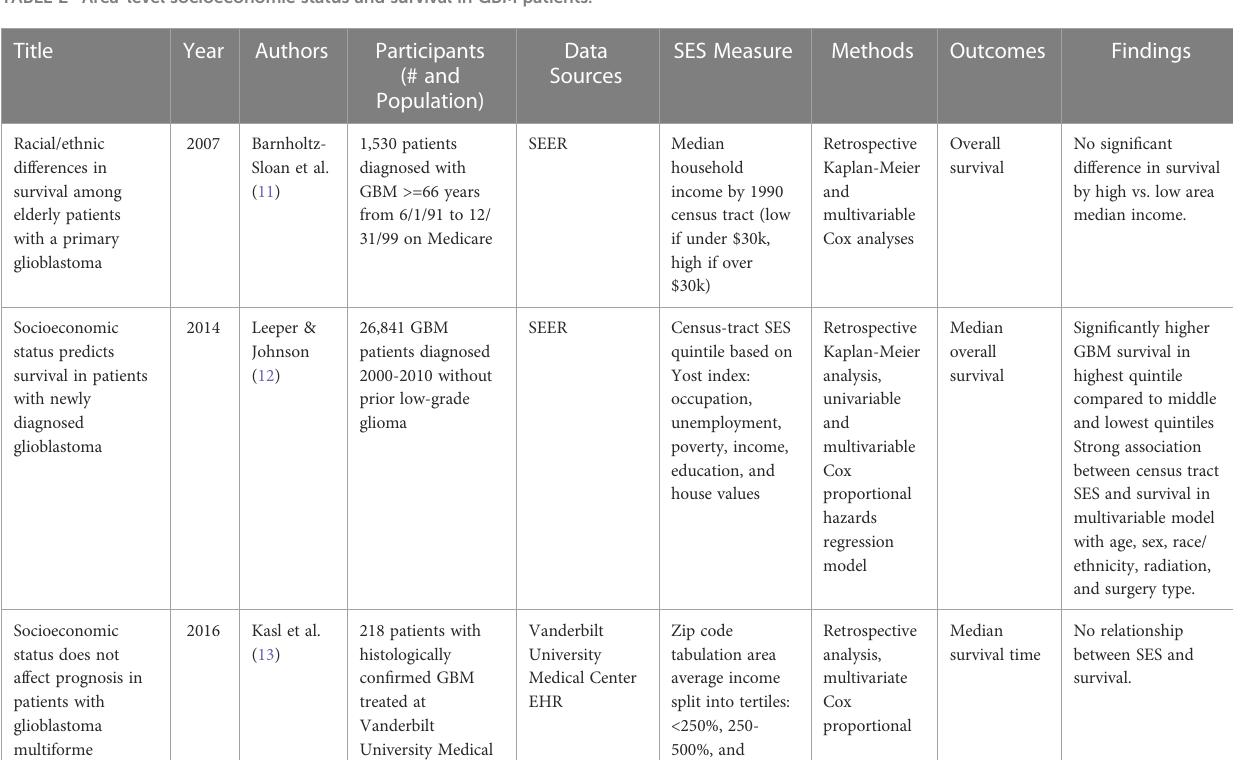
TABLE 2 Area-level socioeconomic status and survival in GBM patients.